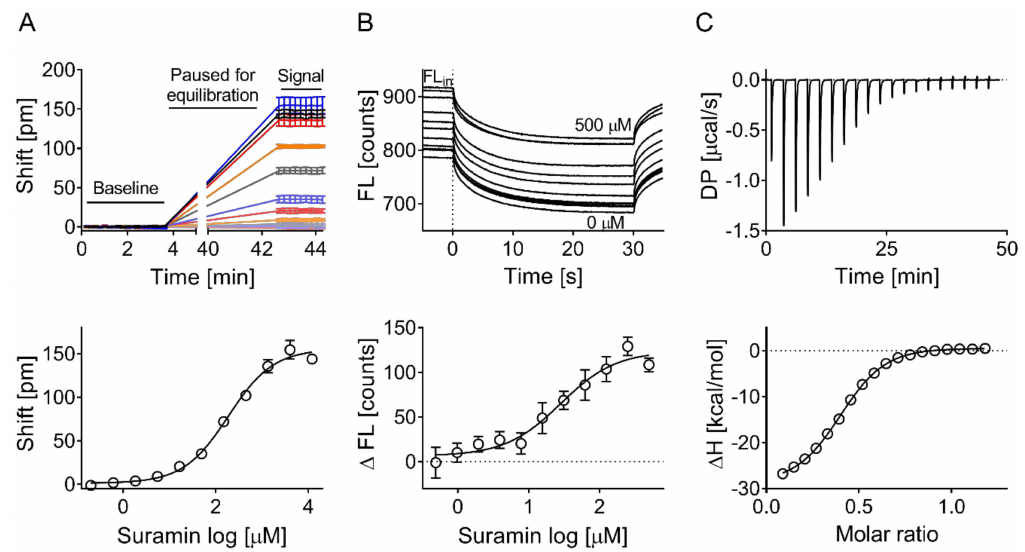
Figure 3. Suramin concentration response across the three biophysical assays. Binding of suramin was confirmed ( A ) on the Corning Epic biochemical assay, ( B ) by microscale thermophoresis, and ( C ) by isothermal titration calorimetry. Mean binding affinities ( ± SD) of 184 ± 18, 28 ± 8, and 3 ± 0.4 µ M were calculated across the three assays, respectively. ( A ) Typically, 10–15 points in total were recorded to measure the baseline before compound or suramin addition. Each point is the average of 4 × 3 s scans. After reading the baseline, the run was paused, the compound added, and the plate returned into the Epic reader for thermal equilibration. The binding signal expressed as shifts in reflected wavelength (picometer) was then measured for 10–15 more points in total. ( B ) Initial fluorescence (Fl in ) of fluorescently labelled ApoE4 was measured before applying the infrared laser to induce thermophoresis. Suramin increased the initial fluorescence in a concentration-dependent fashion. Data in ( A ) and ( B ) are expressed as mean ± SD of three independent experiments. FL: fluorescence; DP: differential power; ∆ H: enthalpy.